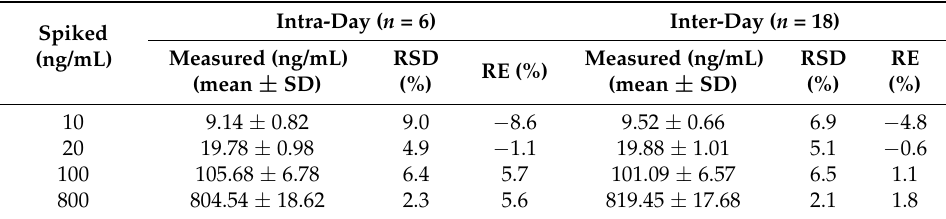
Table 1. Summary of accuracy and precision for the determination of sodium danshensu in beagle dog plasma.